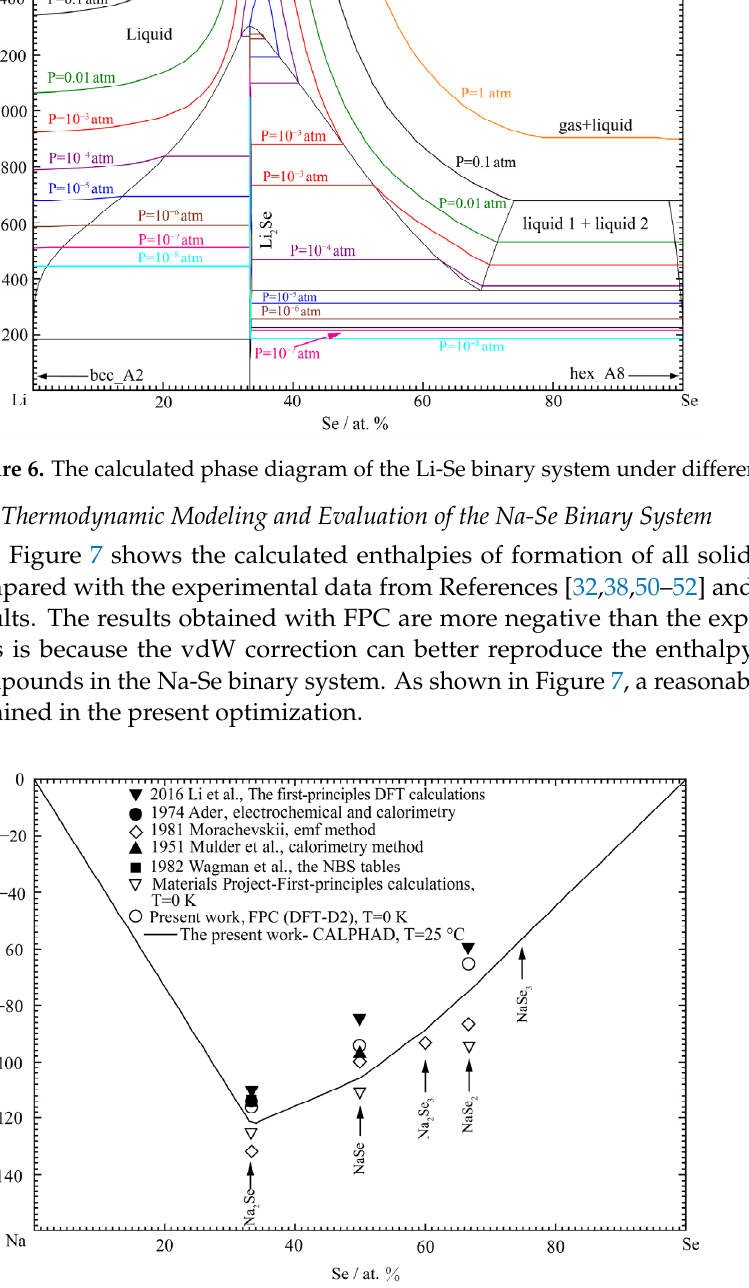
Figure 7. The calculated enthalpy of formation of the Na-Se binary system at 25 °C compared with the previously reported data [32,38,50–52] and the present DFT results.